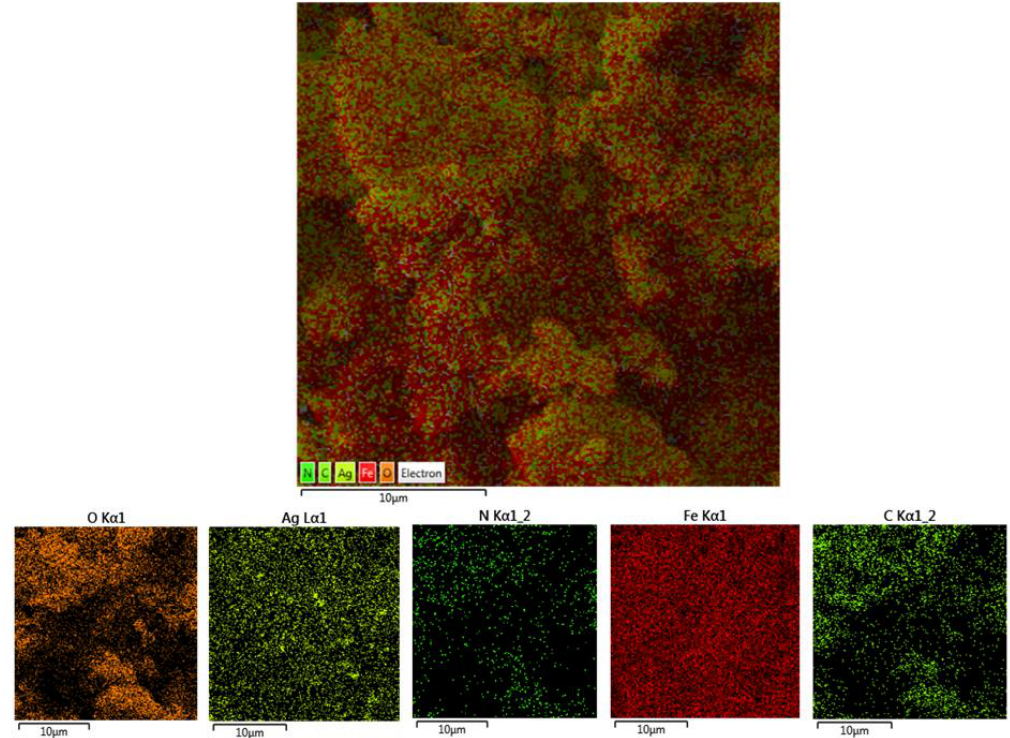
Figure 5. Energy dispersive X-ray (EDX) mapping of the catalyst Fe 3 O 4 @CS@MS@Ag before the catalytic reaction.